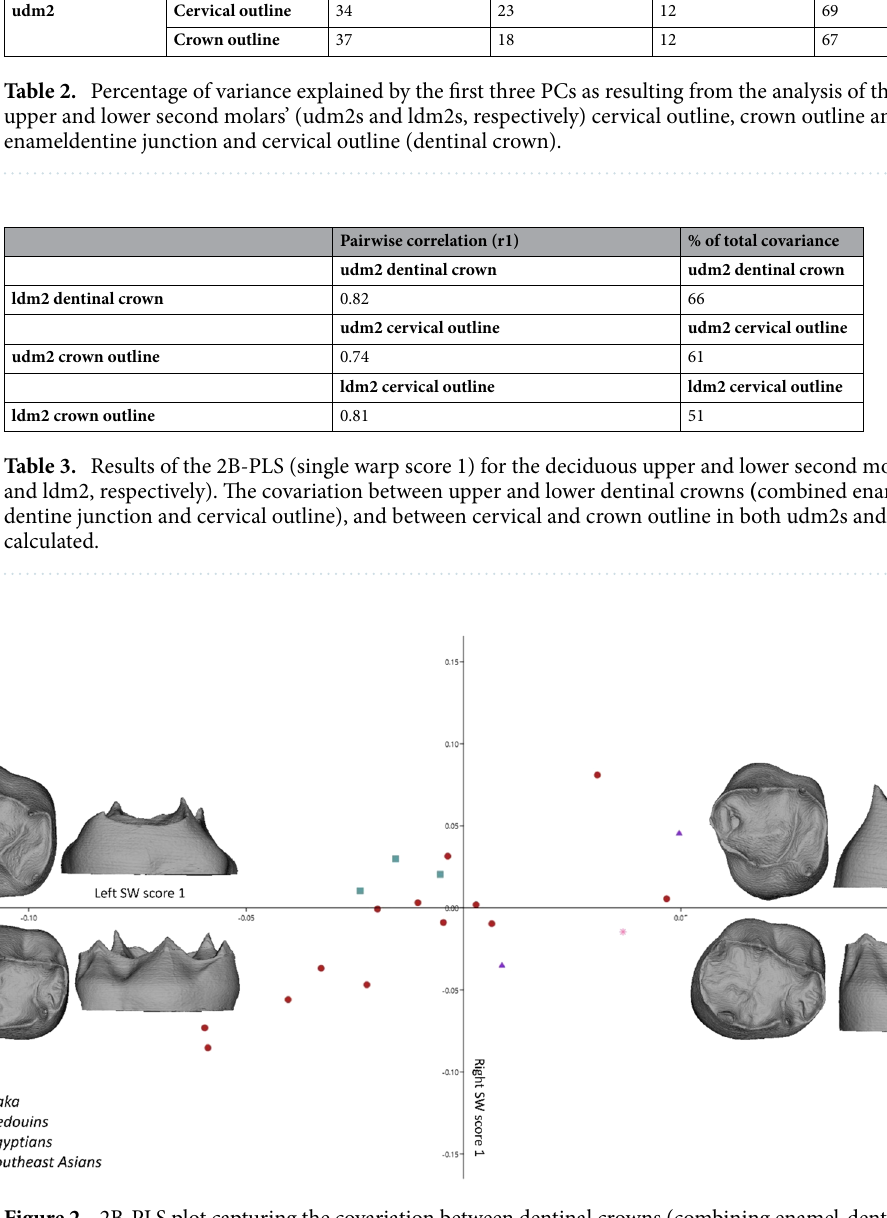
Figure 2. 2B-PLS plot capturing the covariation between dentinal crowns (combining enamel-dentine junction and cervical outlines) of deciduous upper and lower second molars (dm2s; warpings at values ± 0.15). The upper and lower dm2 dyads vary from low-crowned with expanded opposing fossae to high-crowned with reduced opposing fossae. The various populations can be hardly distinguished, although the subsample sizes are too small to allow definite statements. Within the Baka sample the most extreme expression towards the low- crowned variation is